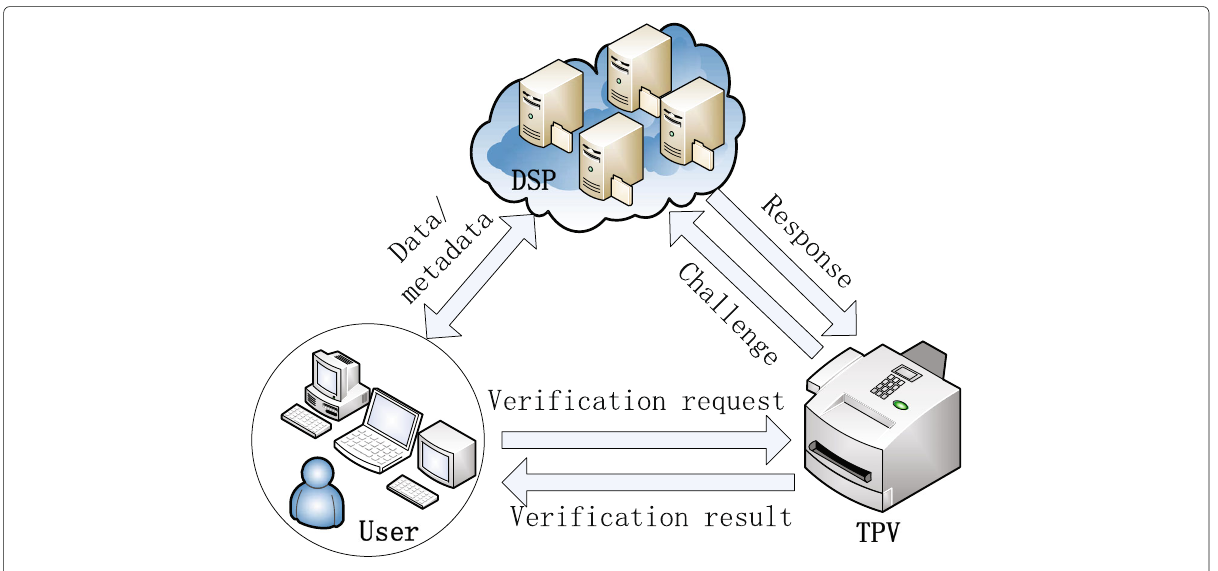
Fig. 1 Data integrity verification